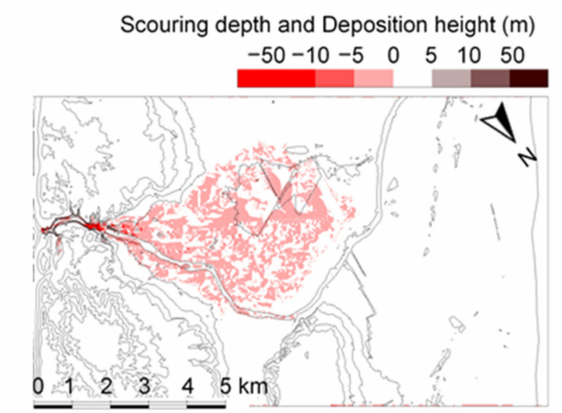
Figure 15. (Case–1). Topography change, 20 min after the start of the